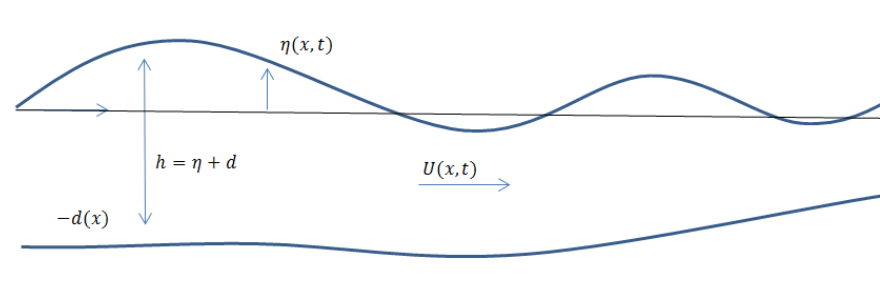
Figure 1. Description of the variables used in Shallow Water Equations (SWEs).